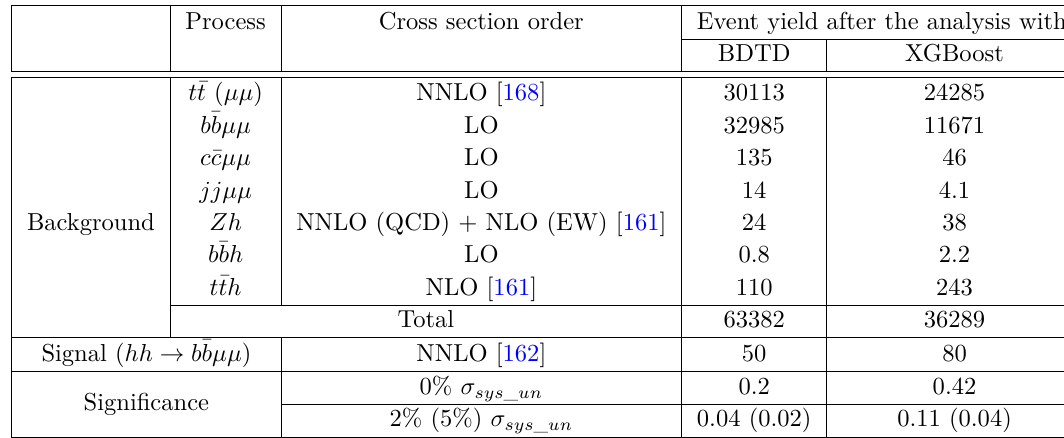
Table 9 . The signal and background yields at the HE-LHC along with the signal significance for the b ¯ bµ + µ − channel from the analysis using the BDTD and the XGBoost classifiers. the two final state muons) and all the variables have their usual meaning. The kinematic variables which are most effective in discriminating the signal from the backgrounds in the BDTD analysis are: m , m , /E and p . We illustrate the normalized µµ T,µµ bb T